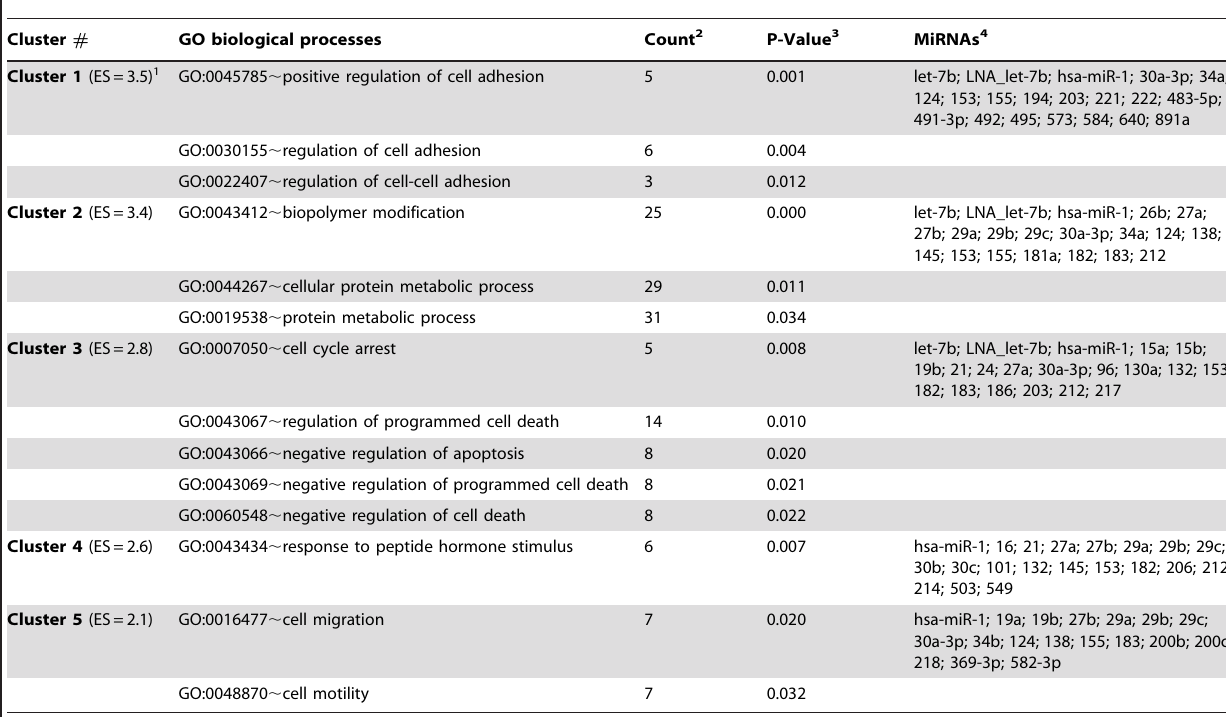
Table 3. Functional annotation clusters of enriched GO biological processes predicted to be stimulated by miRNA downregulation in senescent IMR90 fibroblasts.